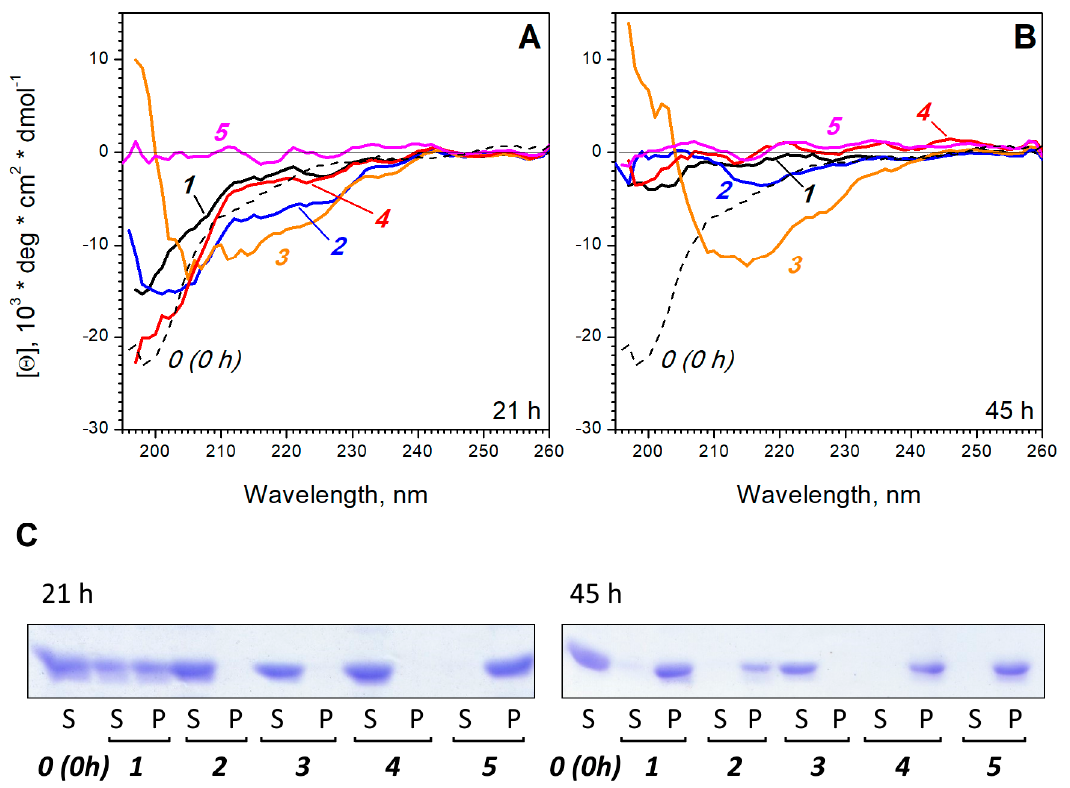
Figure 3. Circular dichroism spectra of intact alpha-synuclein monomers before incubation under fibrillation conditions (0) and after the incubation for 21 h ( A ) and 45 h ( B ) in free form (1) and in the presence of 5 mM PSS (2), PAS (3), PEVP (4) and PEVP-50% (5). ( C ) SDS-PAGE of supernatant (S) and pellet (P) fractions of the same samples 0–5 centrifuged for 10 min at 12,000× g .